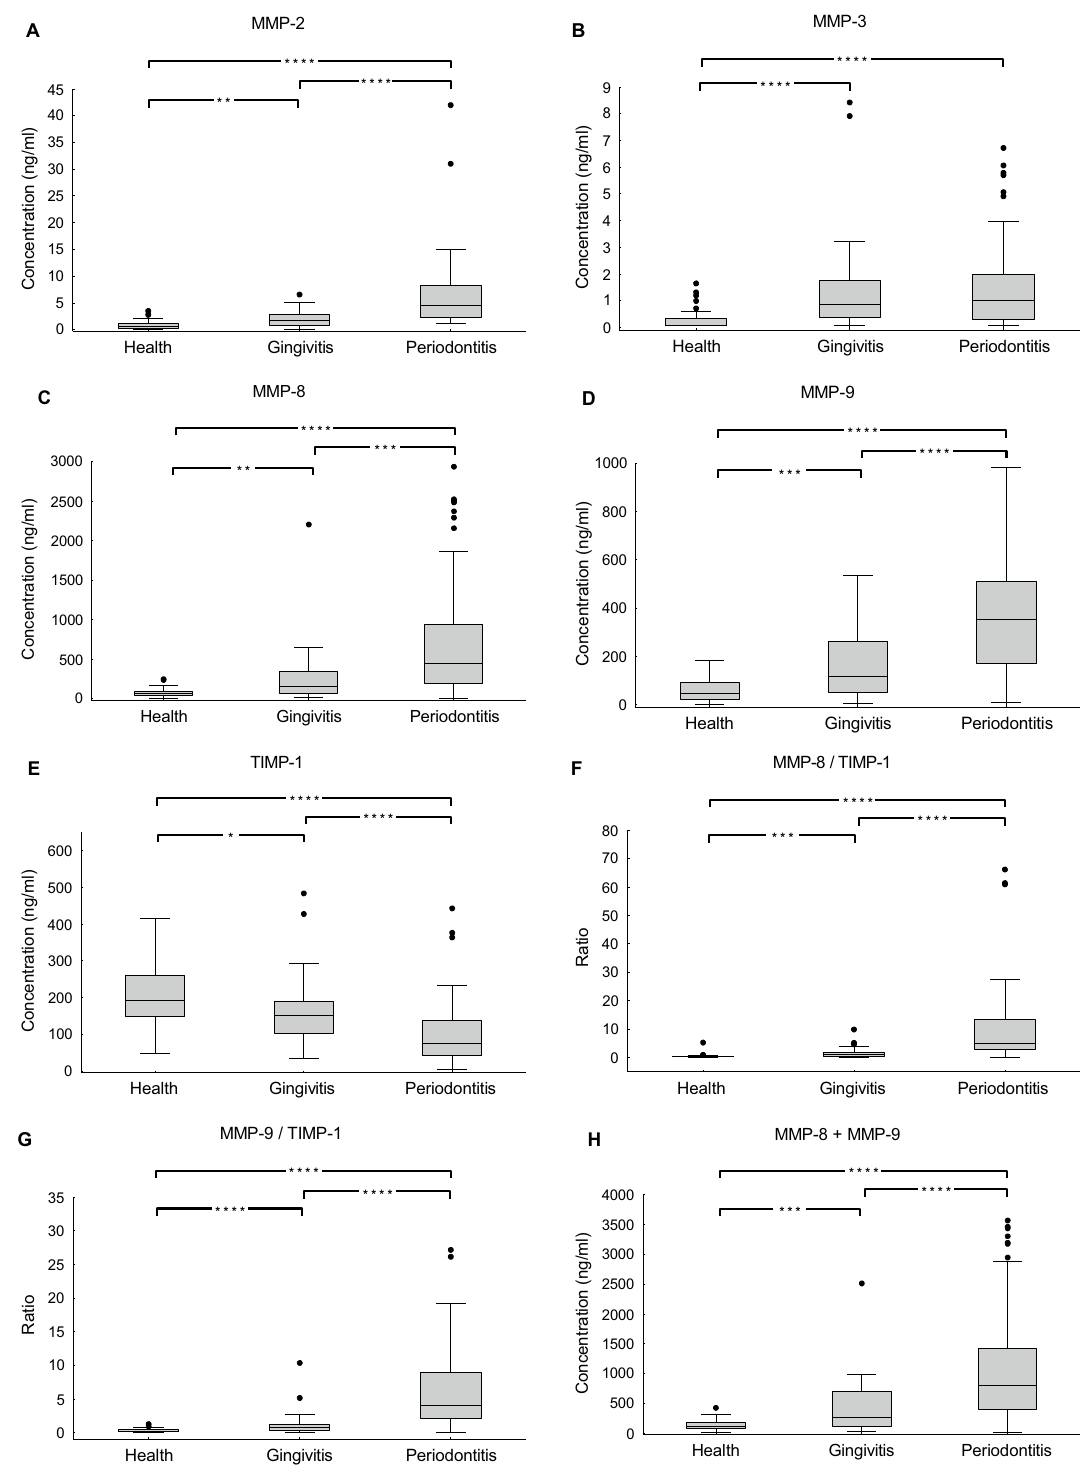
Figure 1. Box plots of the selected markers (and combinations thereof) showing levels of each in saliva from individuals in a comparison between health, gingivitis and periodontitis groups: ( A ) MMP-2; ( B ) MMP-3; ( C ) MMP-8; ( D ) MMP-9; ( E ) TIMP-1; ( F ) MMP-8/TIMP-1; ( G ) MMP-9/TIMP-1; ( H ) MMP-8 + MMP-9; ( I ) (MMP-8 + MMP-9)/TIMP-1; ( J ) LBP; ( K ) OPG; ( L ) IL-1b; ( M ) IL-8; ( N ) HGF. The boxes represent the values from the 25 th to the 75 th percentile. The middle lines represent the medians. The vertical lines extend from the minimal to the maximal values. (*) for p < 0.05; (**) for p < 0.01; (***) for p < 0.001; (****) for p <